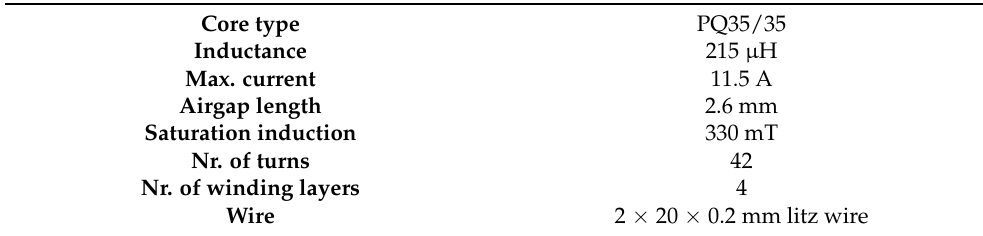
Table 1. Main parameters of PFC inductor v1 for the case study of delimitation of the space around